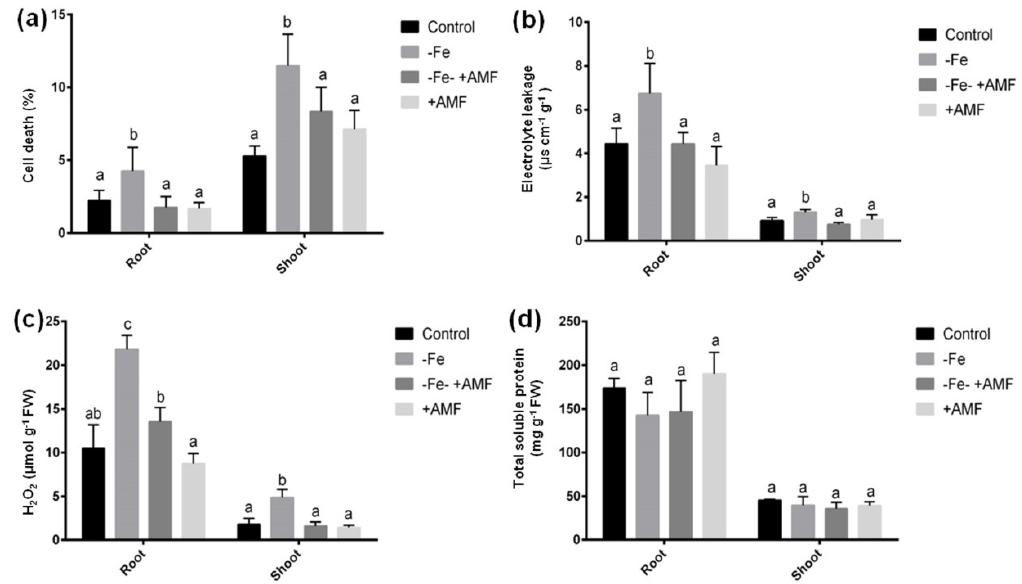
Figure 4. E ff ects of Fe deficiency and AMF on oxidative stress indicators in alfalfa. ( a ) Cell death, Figure 4. Effects of Fe deficiency and AMF on oxidative stress indicators in alfalfa. (a) Cell death, (b) ( b ) electrolyte leakage, ( c ) H 2 O 2 accumulation, and ( d ) changes of total soluble protein. Data represent electrolyte leakage, (c) H 2 O 2 accumulation, and (d) changes of total soluble protein. Data represent means ± SD ( n = 3). Di ff erent letters indicate significant di ff erence at p < 0.05 means ± SD ( n = 3). Different letters indicate significant difference at p < 0.05 level.